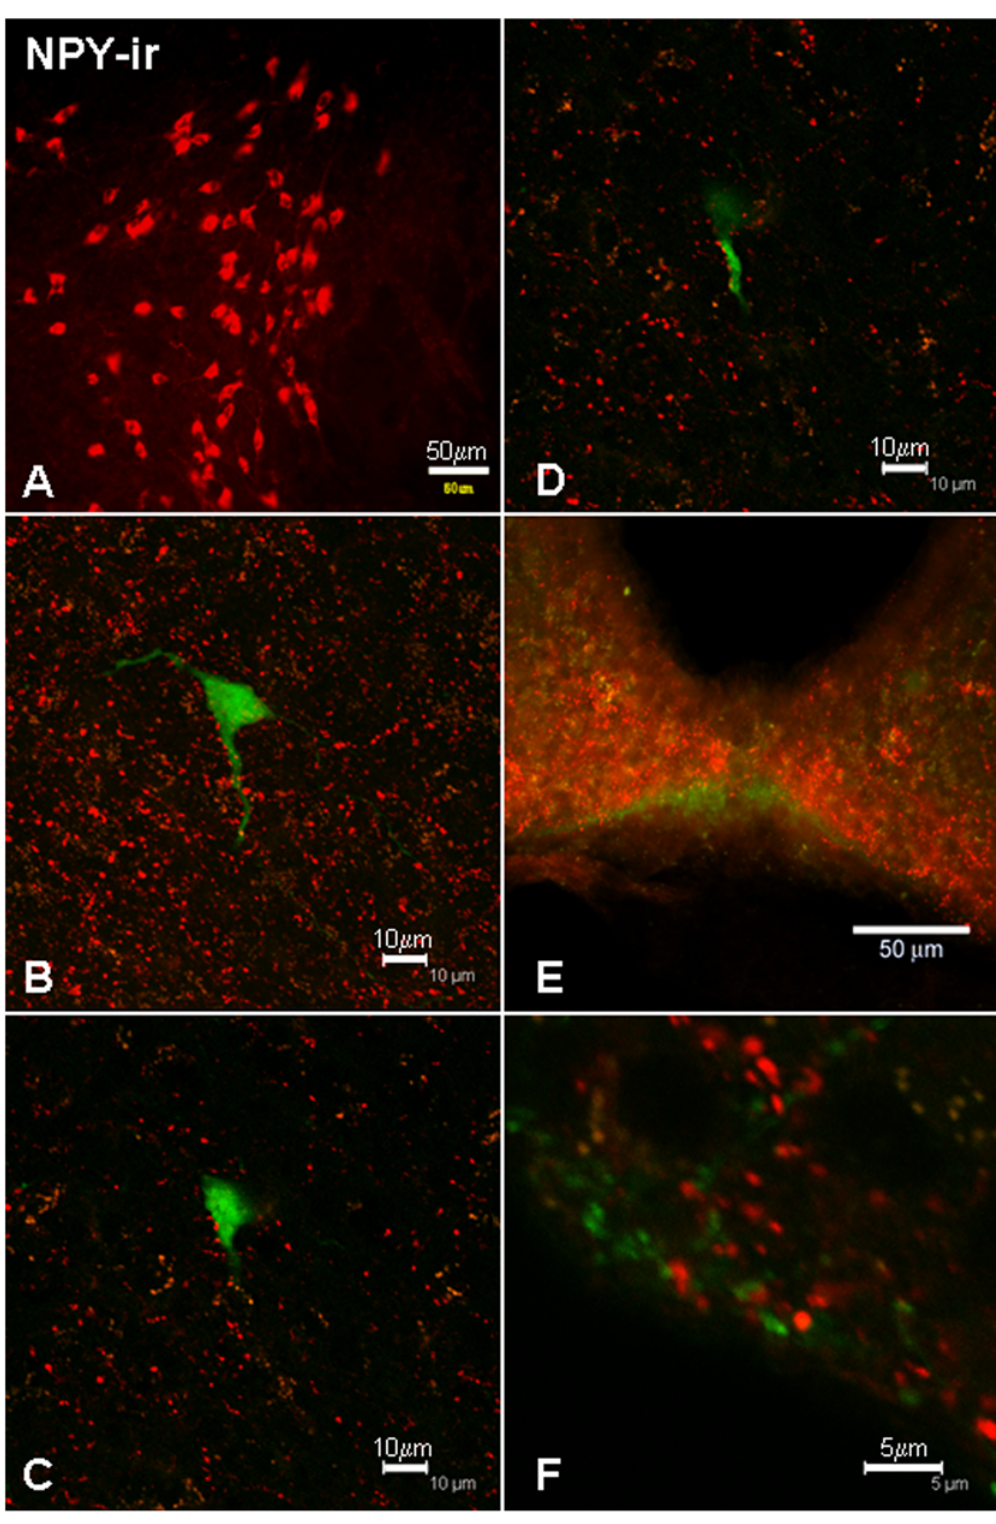
Figure 3. A: NPY-ir perikarya localized in the arcuate nucleus. Examples of close appositions between NPY-ir fibers (red) and GnRH-GFP perikarya and processes (green) in a maximum intensity projection of the image stack ( B ) and in single 0.5 m m optical slices ( C, D ). NPY-ir fibers and GnRH-ir terminals were observed in proximity in the median eminence ( E ), where the presence of close appositions was confirmed by analysis of single 0.5 m m optical slices ( F ). Scale bars=50 m m ( A ), 10 m m ( B–D ), 50 m m ( E ), 5 m m ( F ).